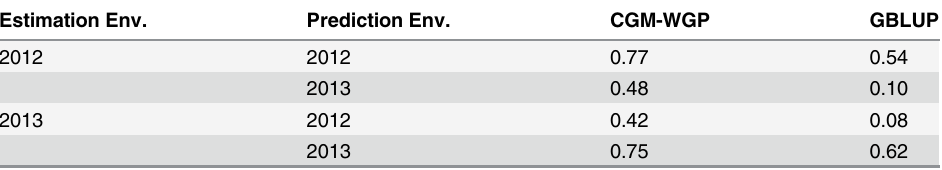
Prediction accuracy for grain yield of DH lines in the test set, averaged over 50